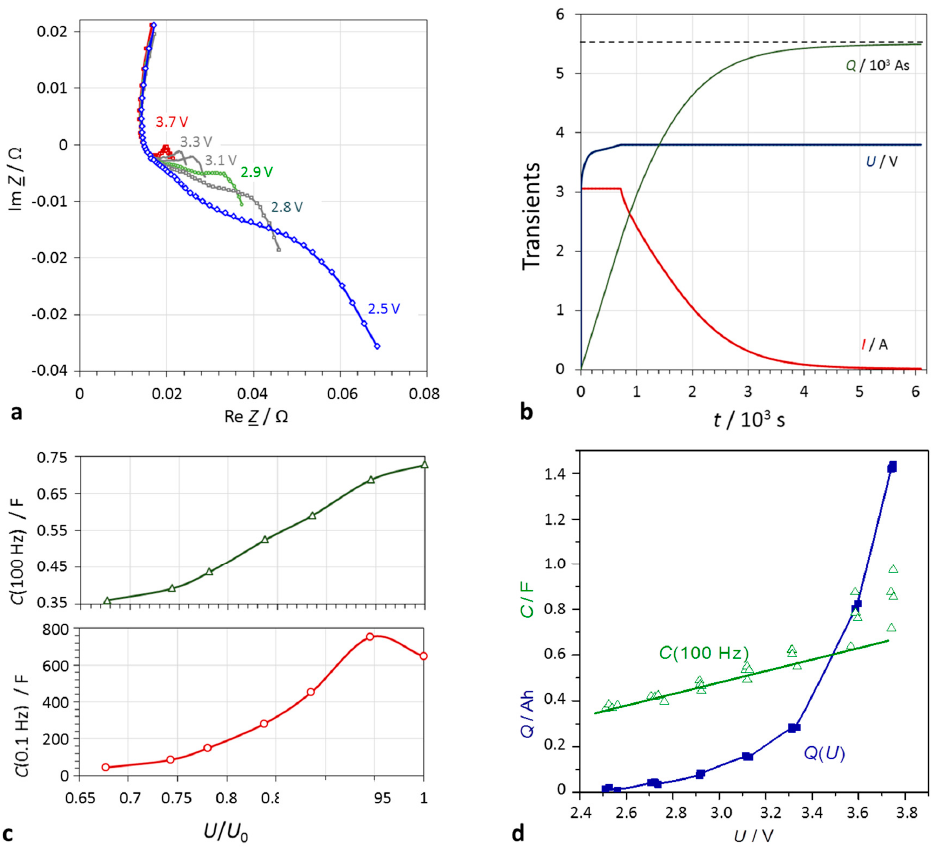
Figure 6. Lithium-ion battery (Samsung INR18650-25R, 1.5 Ah, 3.6 V) at defined SoC states. ( a ) Impedance spectra in the complex plane (mathematical convention): The cell resistance drops with increasing terminal voltage; ( b ) charge characteristics: applied current I , and voltage U , stored charge Q ; ( c ) capacitance at a given frequency (e.g., 100 Hz, and 0.1 Hz) indicates the SoC; ( d ) quasi-linear correlation of capacitance and quasi-exponential correlation of electric charge with cell voltage. Table 2 compiles resistances and capacitances of a lithium-ion battery at different SoC values. Capacitance at 0.1 Hz multiplied by the cell voltage yields the approximate actually available electric charge, Q = CU . This means that DC capacitance reflects the true SoC. The capacitance at 100 Hz directly indicates the SoC: α = ( C + 1.27)/2.59, in the example in Figure 6. However, a useful scaling frequencies. Moreover, it becomes obvious that the state-of-voltage values U / U 0 differ from the real SoC Q / Q 0 .